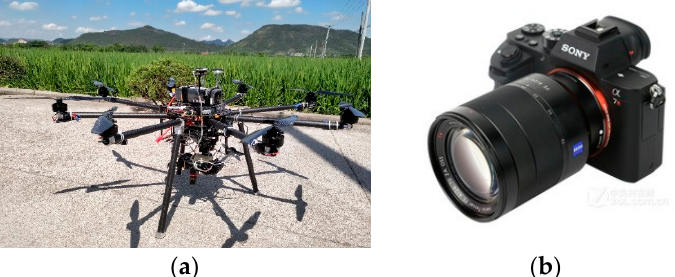
Table 1. Parameters of eight-rotor unmanned aerial vehicle (UAV).